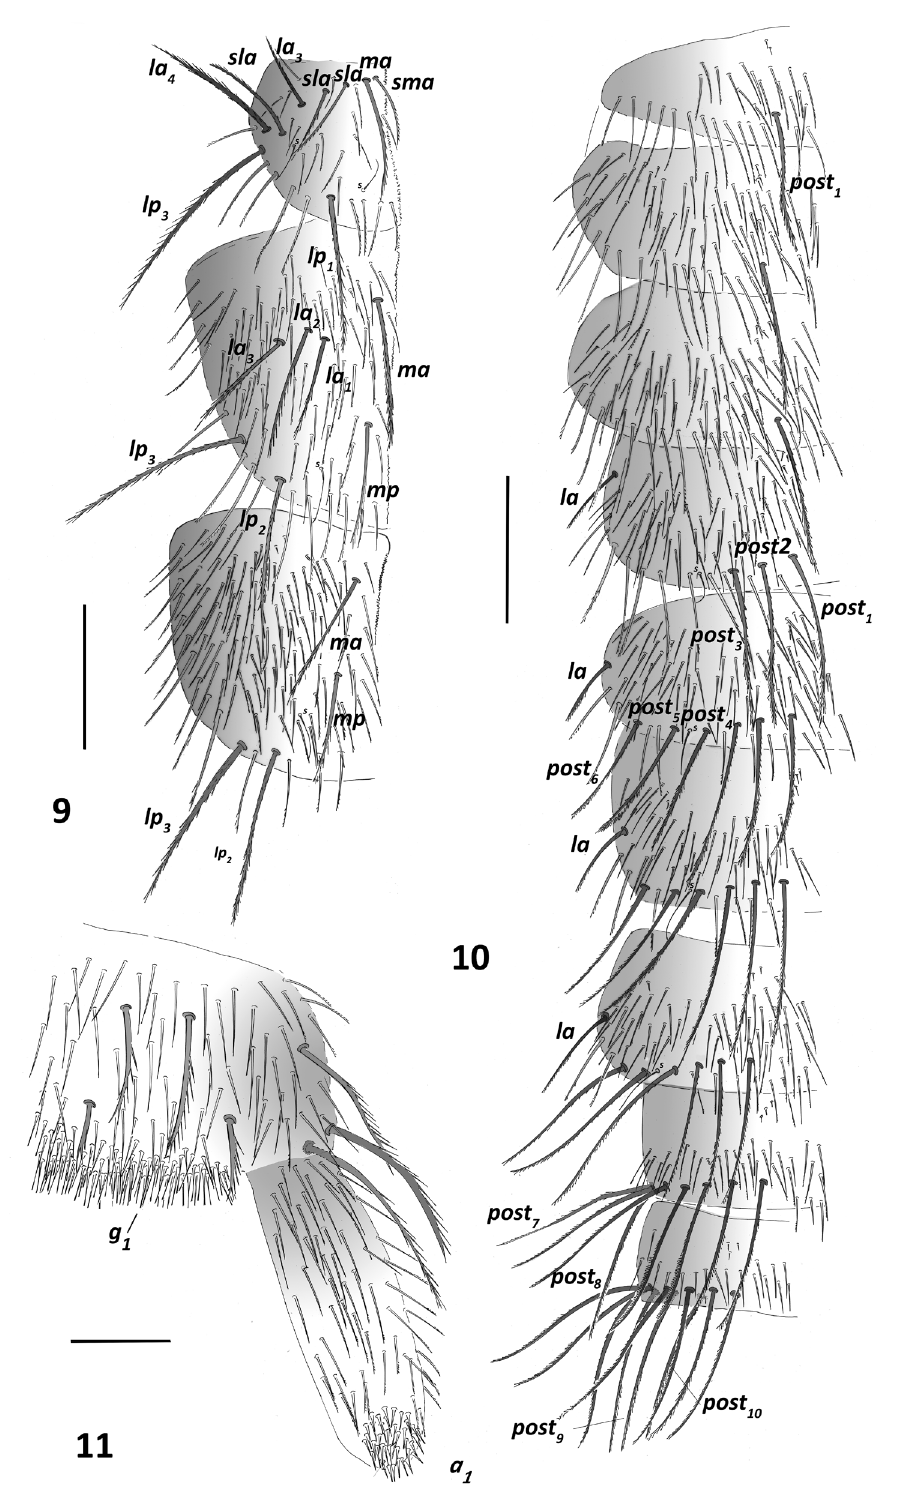
Figs 9–11. Plusiocampa ( Plusiocampa ) apollo Sendra, Giachino & Vailati sp. nov. 9–10 . Holotype, ♀, 4.8 mm long, from Viotìa, O. Pamassós, Greece (MZB 2019-1032). 9 . Pronotum, mesonotum and metanotum (s = setiform sensillum). 10 . Urotergites I–VII and abdominal segment IX, right side ( s = setiform sensillum). 11 . Paratype, ♂, 6.4 mm long, from the type locality (Coll. AS); urosternite I, left side. Scale bars: 9–10 = 30 μm; 11 = 10